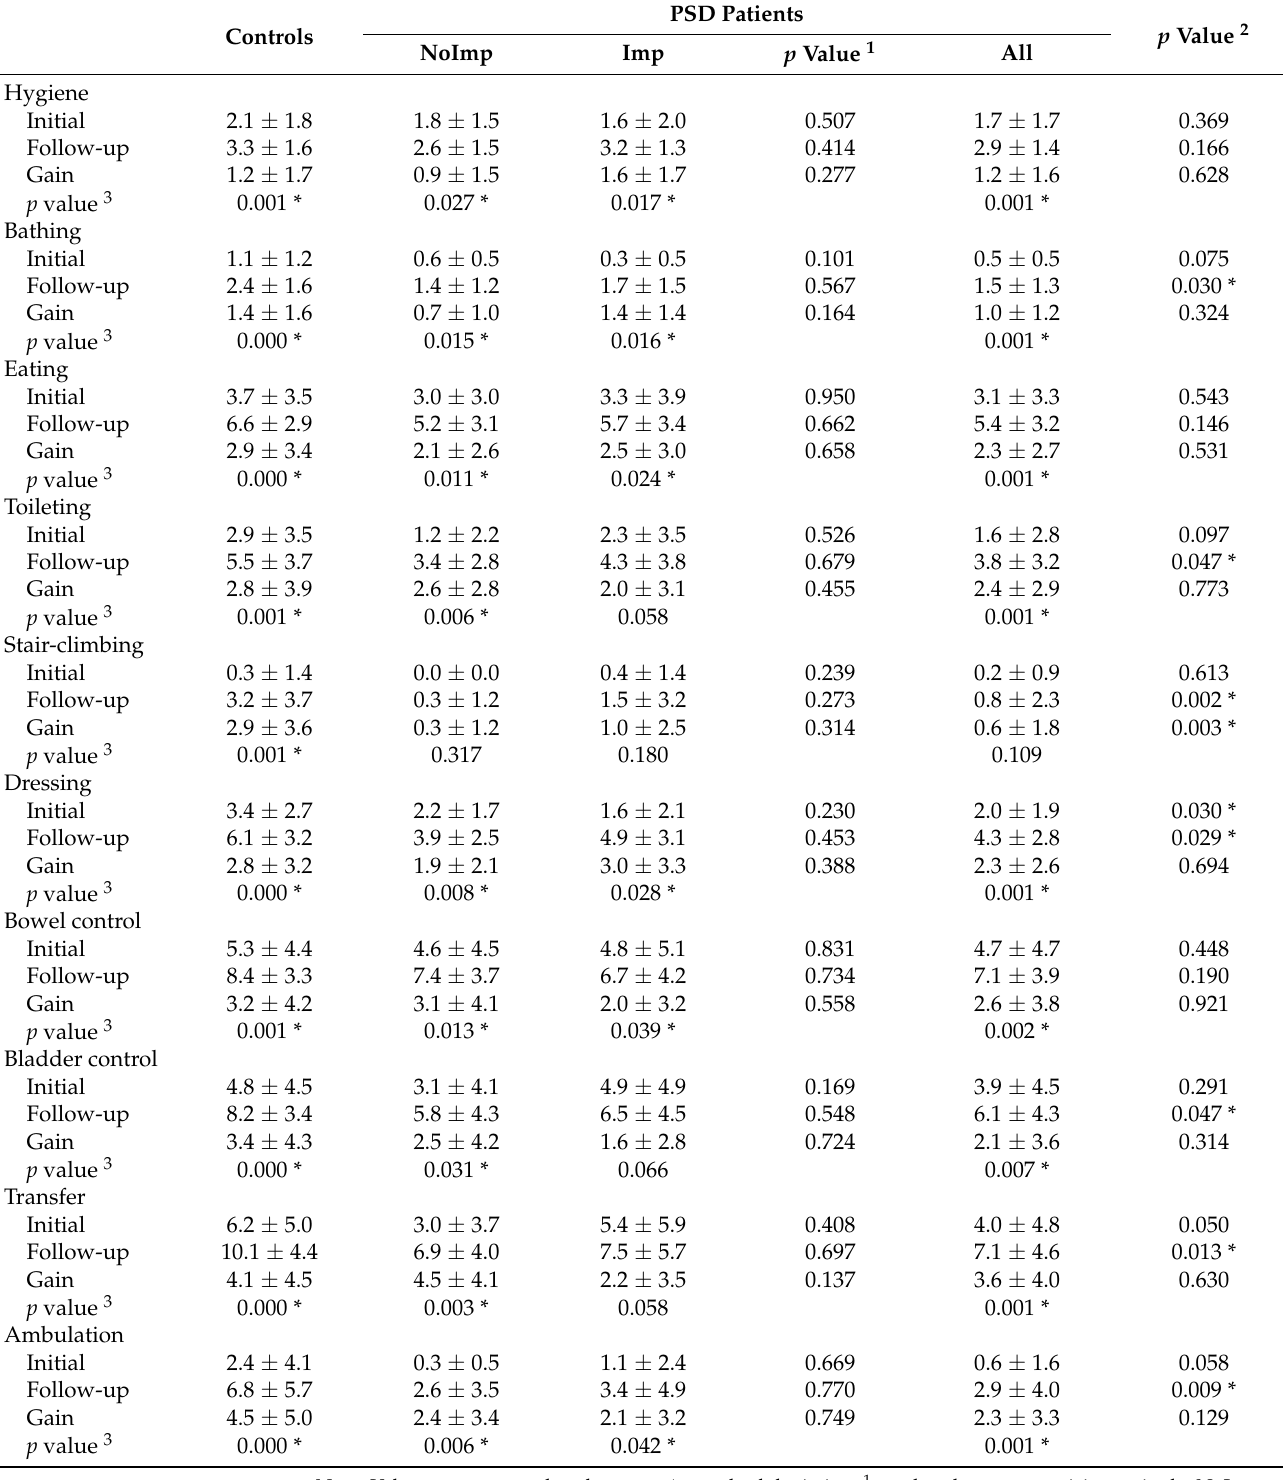
Table 5. Initial and follow-up results of subtests of the K-MBI for controls and PSD patients.